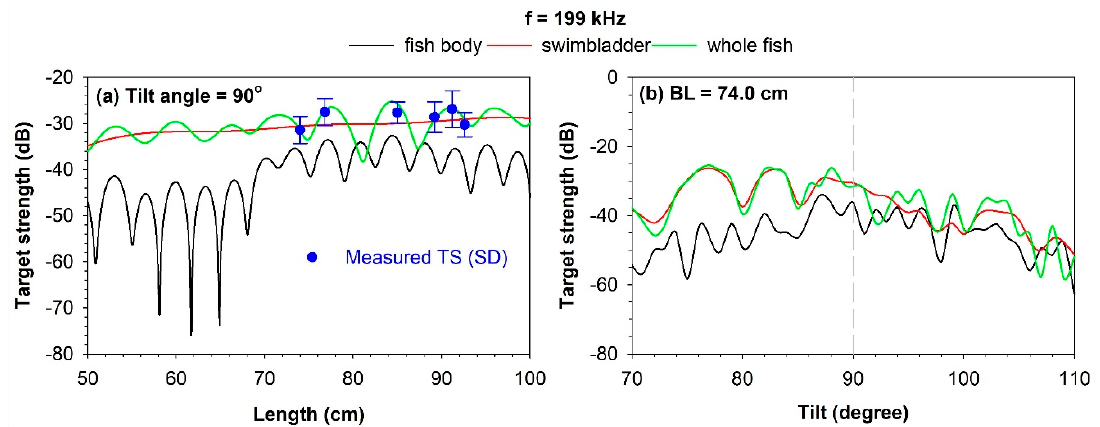
Figure 5. The comparison of measured TS and calculated TS at 199 kHz: ( a ) predicted TS as a function of the body length by the KRM model, where the blue dot with bar indicates the mean TS and its standard deviation of the ex situ measurement from the six specimens (Table 4); and ( b ) calculated TS model for the 74.0 cm specimen as a function of tilt angle (Figure 3).